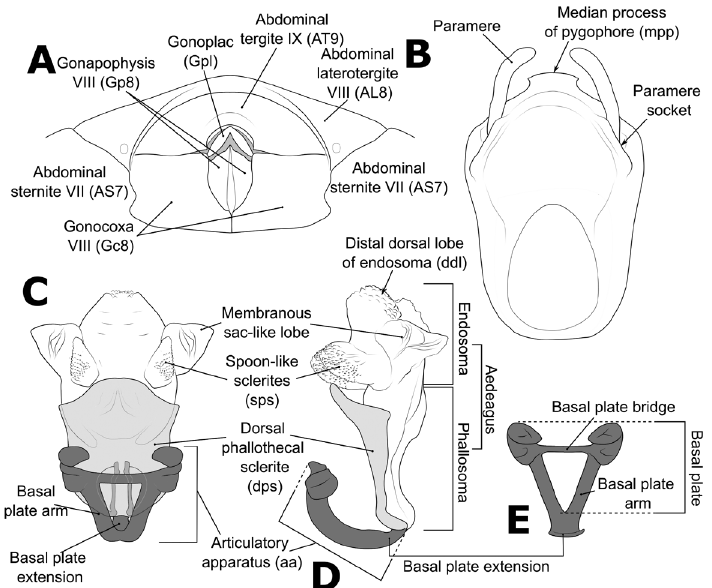
Figure 3. Structure and morphological terms of Biasticus species. Drawing based on Biasticus luteicollis Ha, Truong & Ishikawa, sp. nov. A paratype ♀ HNL2018-024 B–E holotype ♂ HNL2018-025. A female external genitalia in ventral view B pygophore with parameres of male genitalia in dorsal view C phallus in dorsal view D phallus in lateral view E articulatory apparatus in ventral